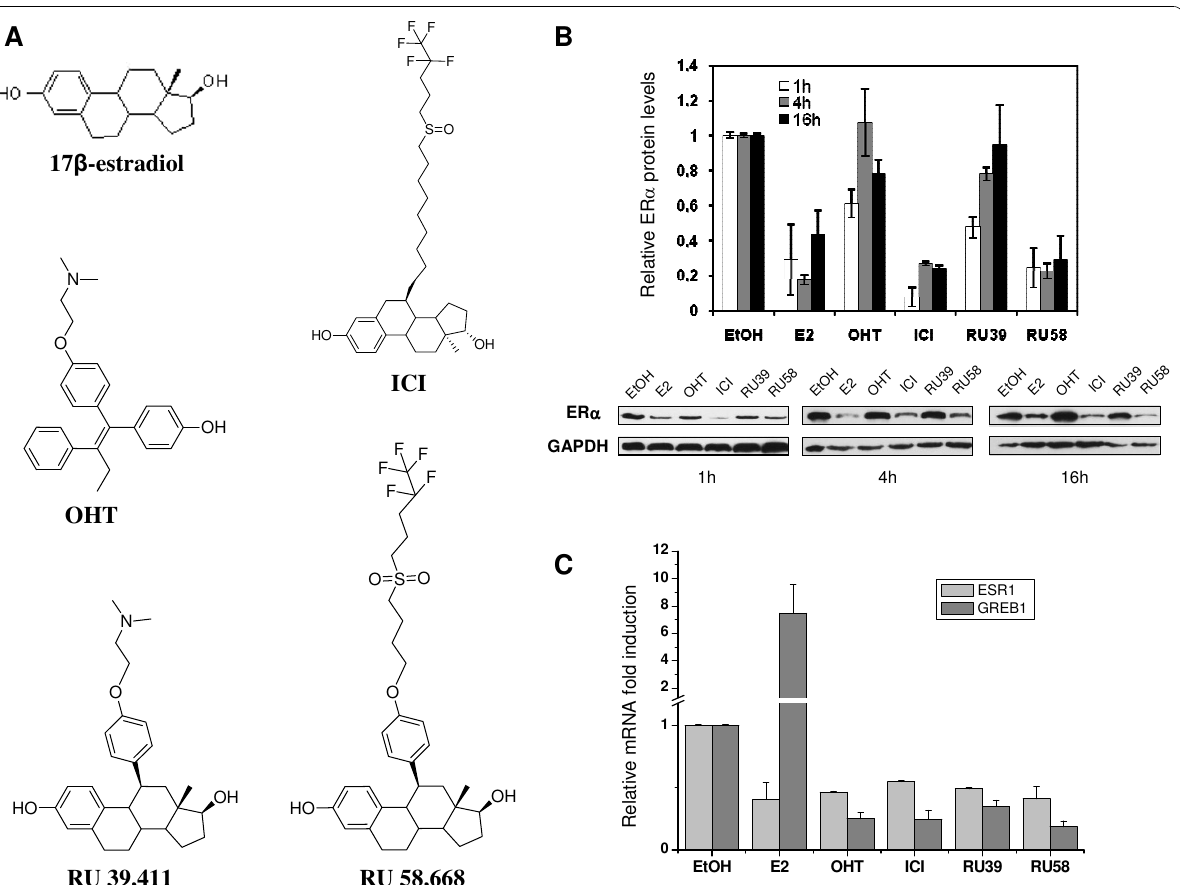
Figure 1 Protein and mRNA levels of ligand bound ER a in MCF-7 cells . A) Chemical structure of 17 b -estradiol, SERMs (OHT, RU39) and SERDs (ICI, RU58). B) Western blot and quantification of ER a protein levels after 1 h, 4 h and 16 h treatment with 10 nM E2, 1 μ M ICI, 1 μ M RU58, 1 μ M OHT and 1 μ M RU39 relative to ER a protein levels in untreated (EtOH) MCF-7 cells. 2 μ g of total protein were loaded. Relative protein levels from three independent experiments were quantified. C) Total RNA was extracted from MCF-7 cells treated or not for 16 h with 10 nM E2 or anti-estrogens. Relative expression level of the ESR1 and GREB1 genes was analyzed by qRT-PCR. TBP served as an internal control (see Methods). Data shown are an average of three independent experiments, error bars represent ± S.E.